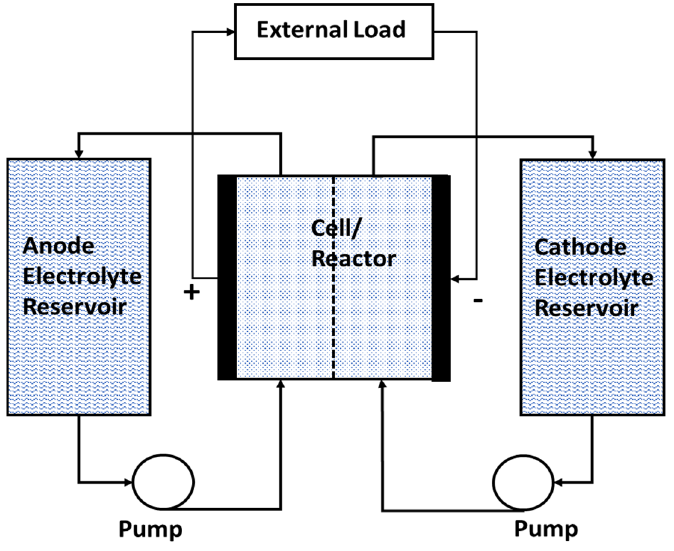
Figure 7 . Schematic diagram of a flow battery. Figure 7. Schematic diagram of a flow